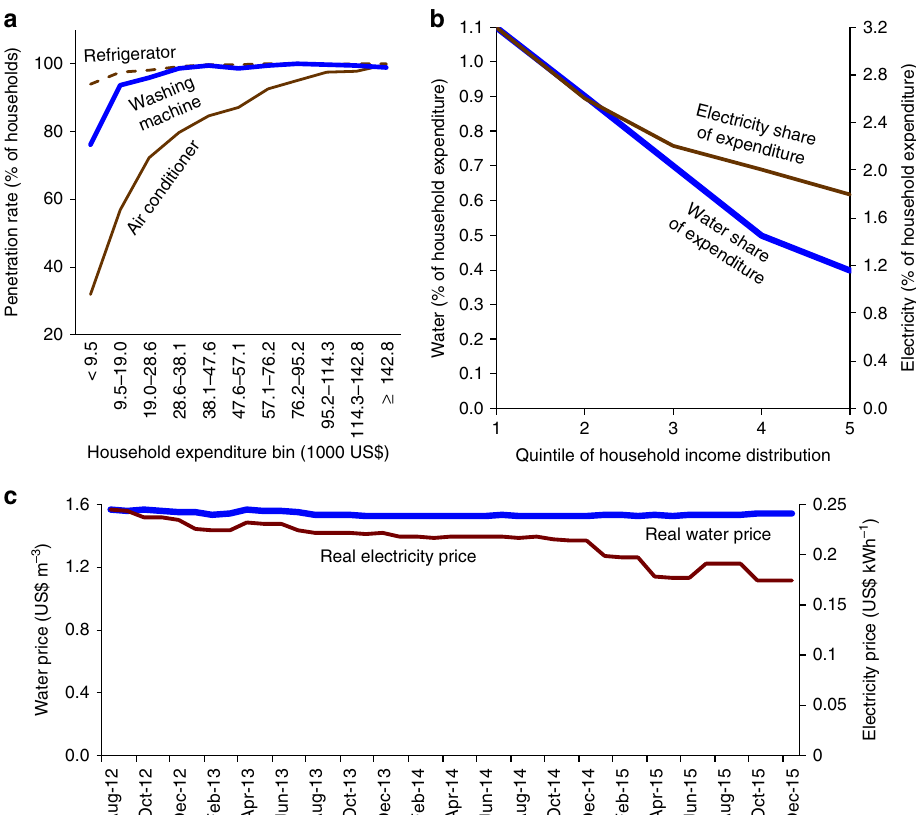
Fig. 1 Appliance adoption and utility expenditure by income. a Household penetration rates (%) for air conditioners, washing machines, and refrigerators, by annual household expenditure bin (1000 US$ at 1.26 SG$ per 1 US$), in 2012/2013. The unit of study is a resident household in Singapore. b Water and electricity shares of household expenditure (%) by quintile of the distribution of household income, in 2012/2013. c Household water and electricity prices (in US$ m − 3 and US$ kWh − 1 , respectively), 2012 – 2015, inclusive of a 7% General Services Tax and adjusted for changes in the Consumer Price Index (base June 2014). Water prices, for volumes up to 40 m 3 month − 1 , include a conservation tax. Sources: 2012/13 Household Expenditure Survey, Energy Market Authority, Public Utilities Board. Source data are provided as a Source Data fi